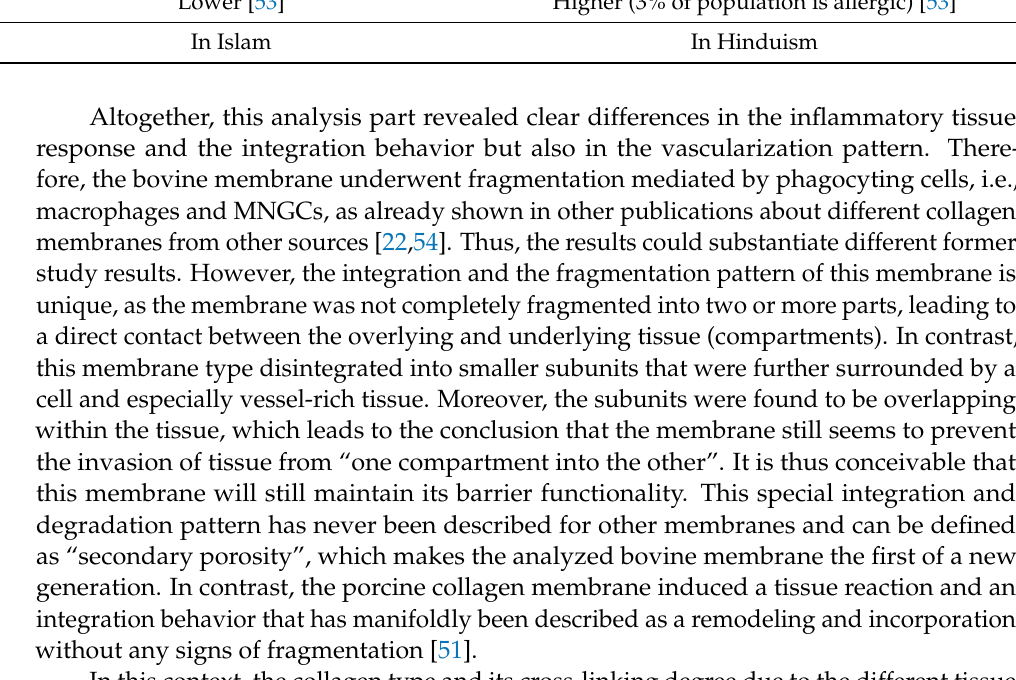
Table 1. Comparison between collagen-based barrier membranes from different xenogeneic resources and extraction sites for Guided Bone Regeneration (GBR). Porcine Bovine Compactness of tissue hinders Compactness of tissue Dermis cell infiltration and degradation Dermis hinders cell infiltration and in vivo [48]. degradation in vivo [48]. Common tissue source Balanced tissue reaction